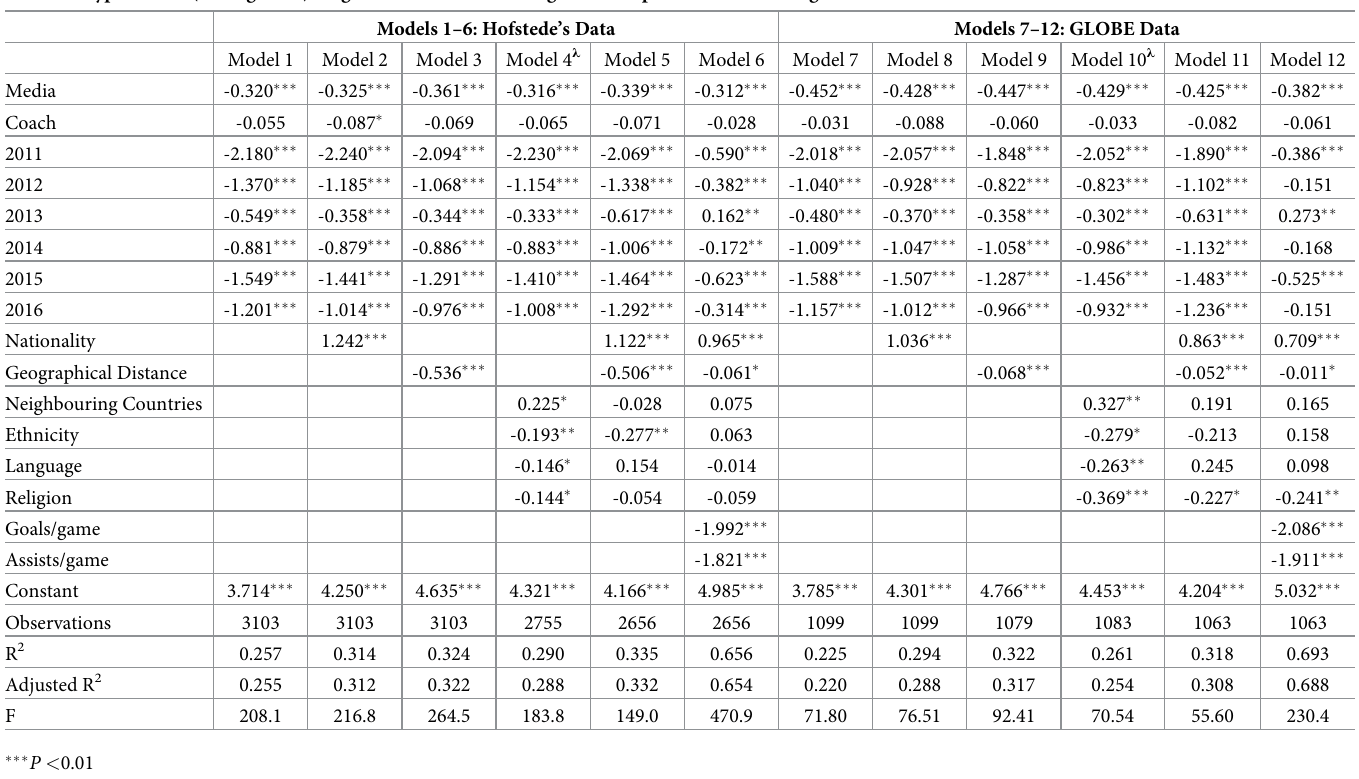
Table 3. Hypothesis 1 (Voting Bias?): Regression models on voting bias for 5 points awarded using both Hofstede and GLOBE data sets. Models 1–6: Hofstede’s